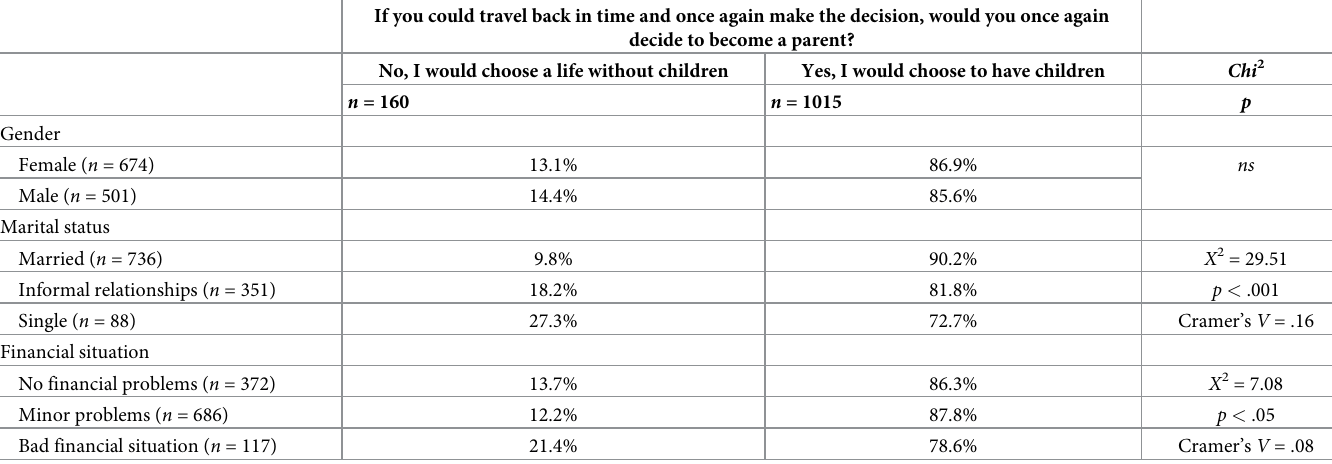
Table 4. Regretting parenthood and gender, marital status, and financial situation (Study